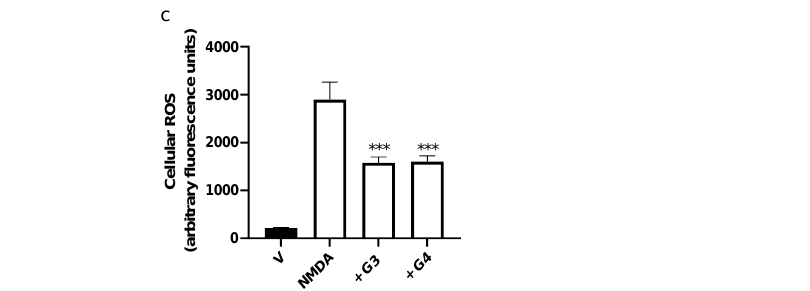
Figure 3. Effect of G3 and G4 phosphorous dendrimers on NMDA-induced changes in Ψ m and ROS levels. Neurons were treated with vehicle (V), G3, or G4 phosphorous dendrimers (10 µ M) for 1 h, and then NMDA (150 µ M) was added. Neuronal ( a ) mitochondria potential, ( b ) mitochondrial ROS, and ( c ) total cellular ROS were determined as indicated in the Materials and Methods section. The data are expressed as the mean + the s.e.m. of 30 to 40 neurons obtained from four independent experiments. *** p < 0.001 as compared to NMDA-treated cells in the absence of dendrimers.